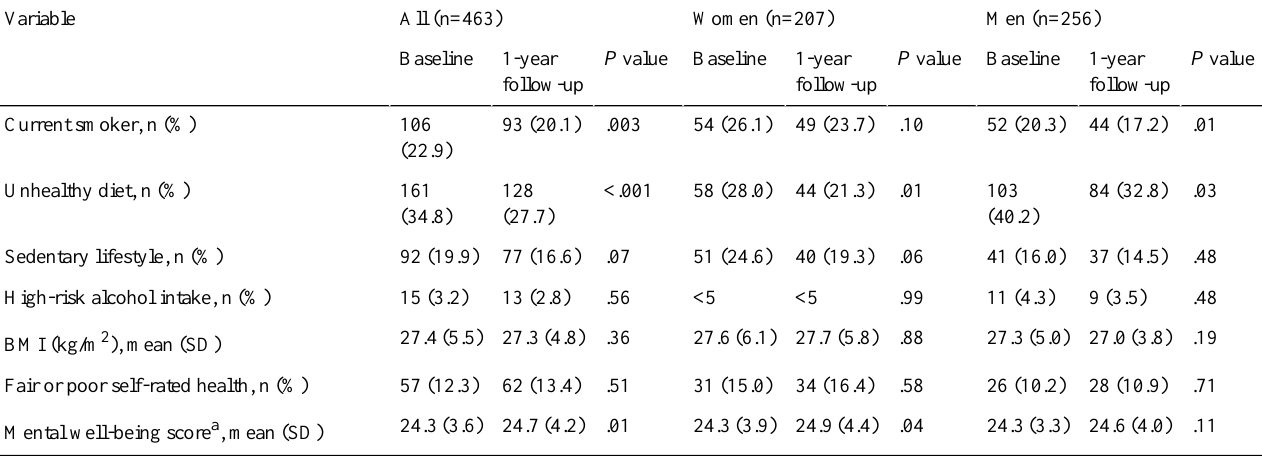
Table 3. Health-risk behaviors, BMI, self-rated health, and mental well-being at baseline and 1-year follow-up among high-risk and health-risk behavior participants receiving the digital personal health profile